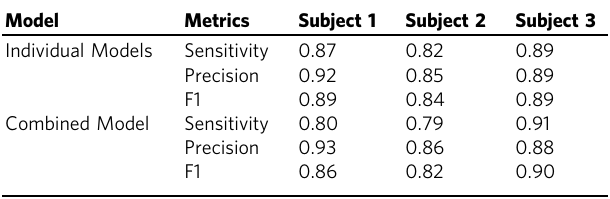
and bottom image pro fi les can be mistaken for smaller neurons/ glial cells, as seen in Fig. S4. The Gaussian mixture model (GMM)